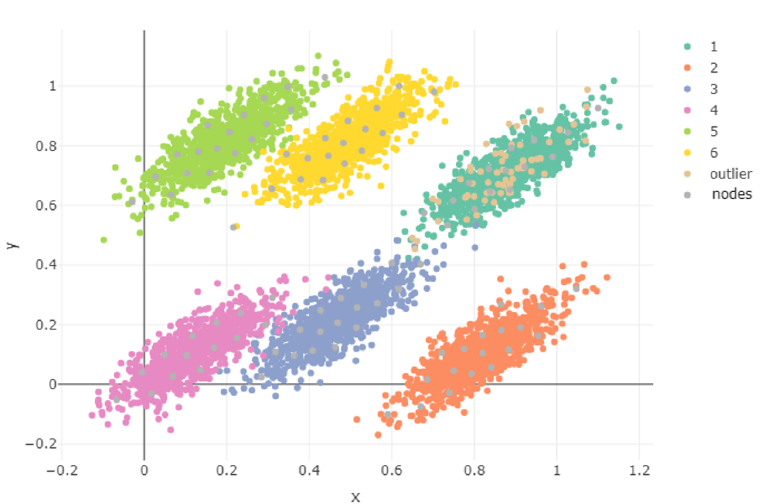
Figure 10. Three-dimensional representation of the data obtained and the weights, without the sample of the component.